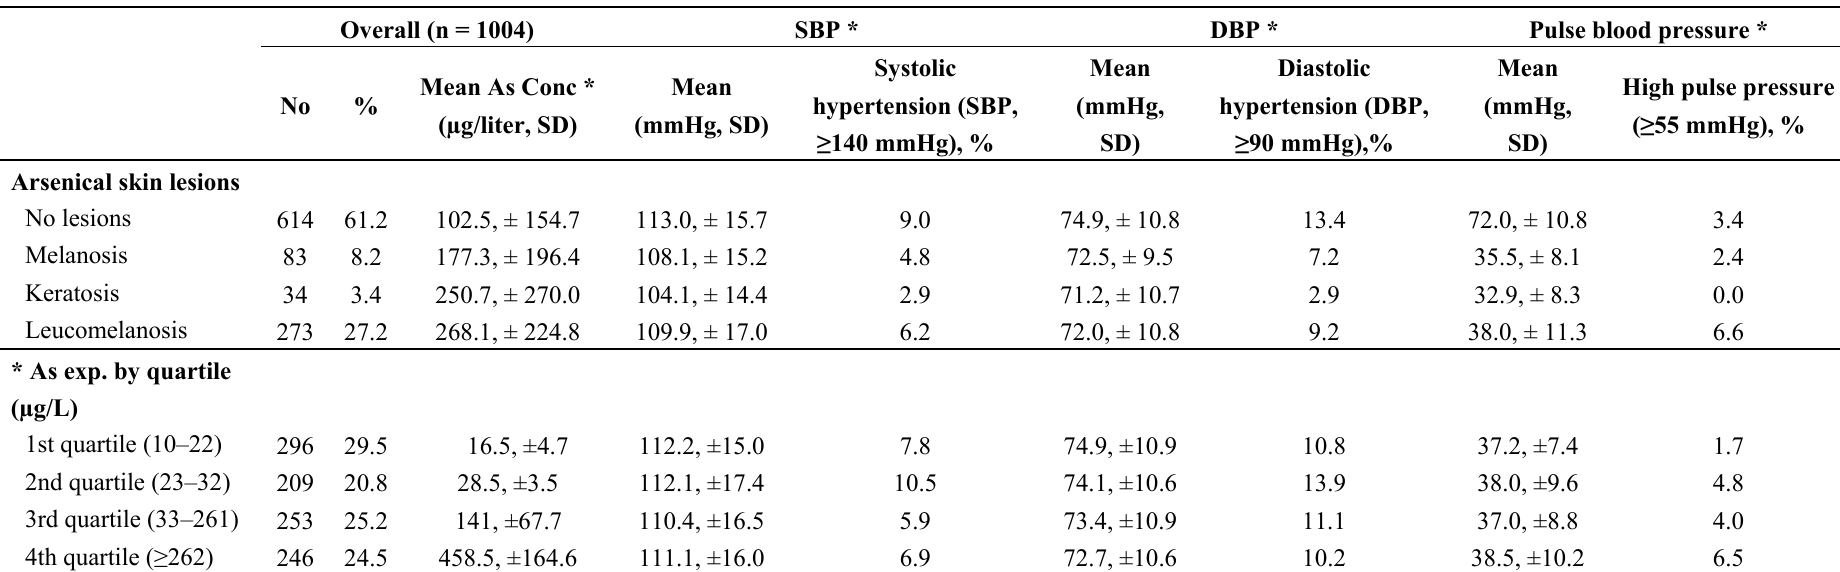
Arsenical skin lesions No lesions